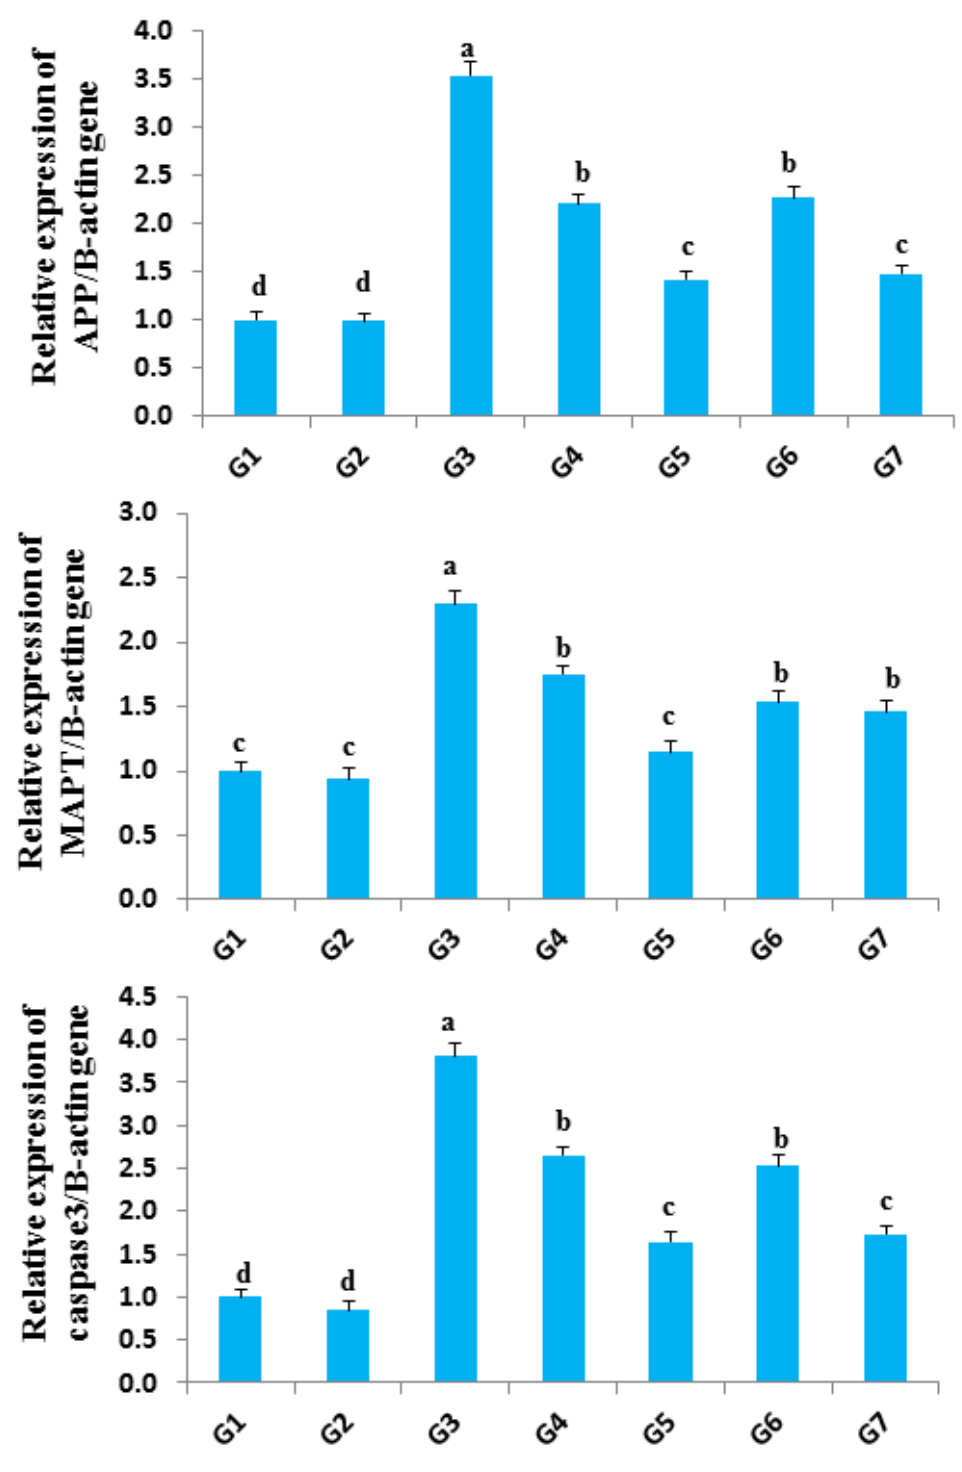
Figure 5. Effect of heavy metal treatment on the expression of APP APP, MAPT, and Caspase3 genes in rat brains.Values with different letters in each column showed a significant difference.